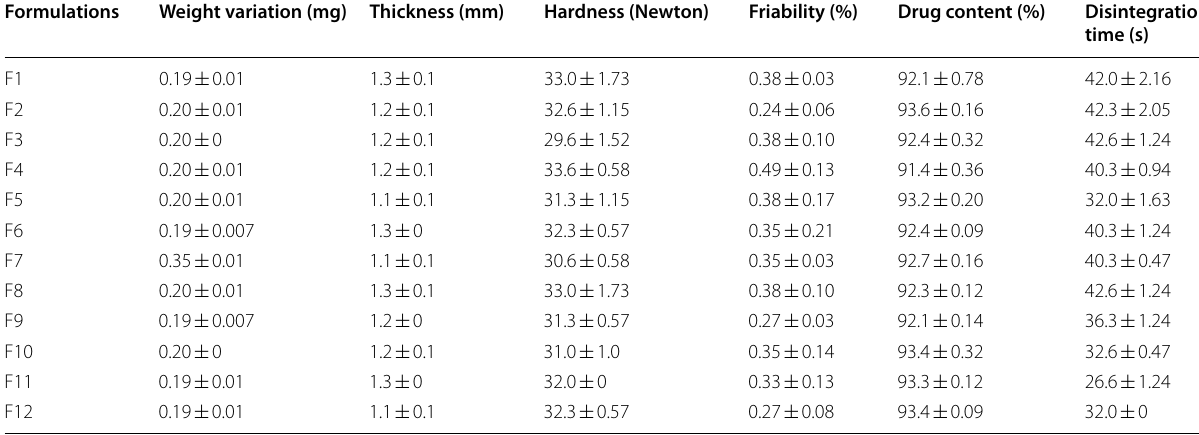
Mean standard deviation, n ±